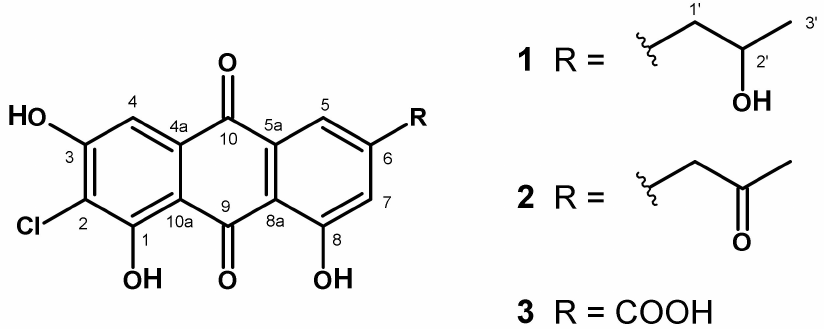
Figure 5. Structures of the new chloroemodines 1 and 2 and 2-chloroemodic acid ( 3 ). 2-Chloro-isorhodoptilometrin